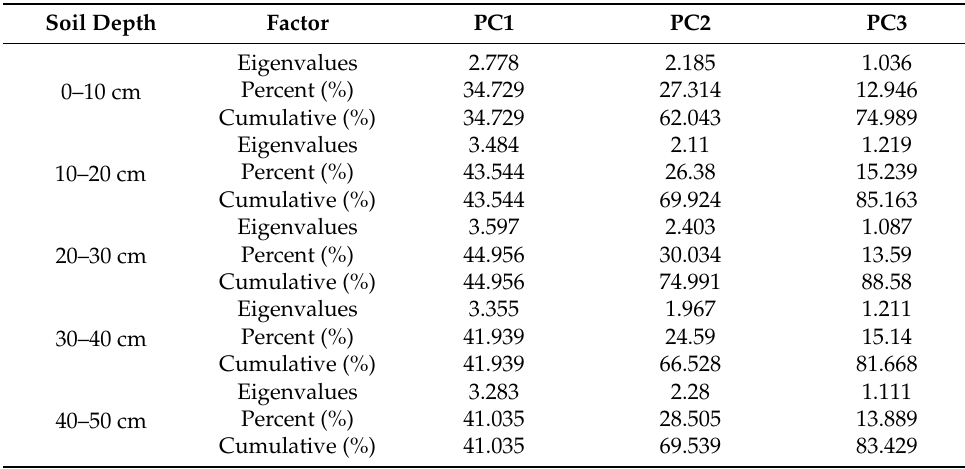
Figure 4. General score of soil nutrients during 2017–2019. Table 2. Eigenvalues and variance contribution